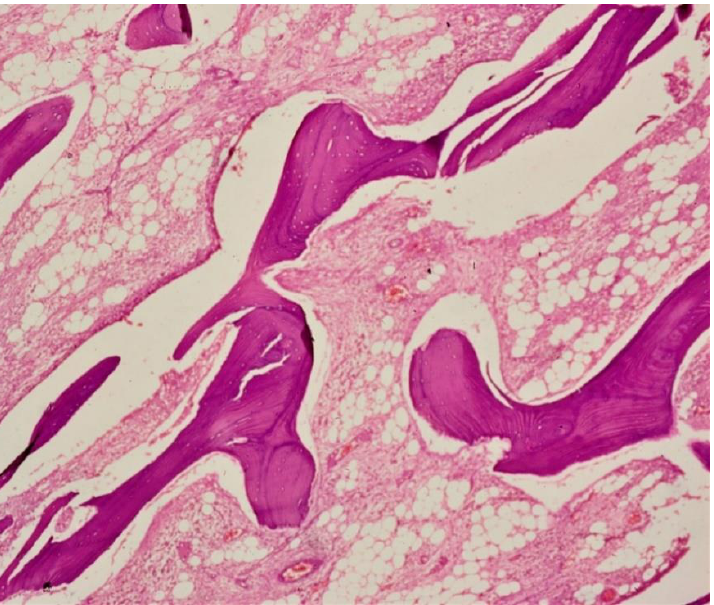
Figure 1. Hematoxylin and eosin (H and E) stained decalcified section showing bony trabeculae of spongy bone with marrow spaces and fat tissue.